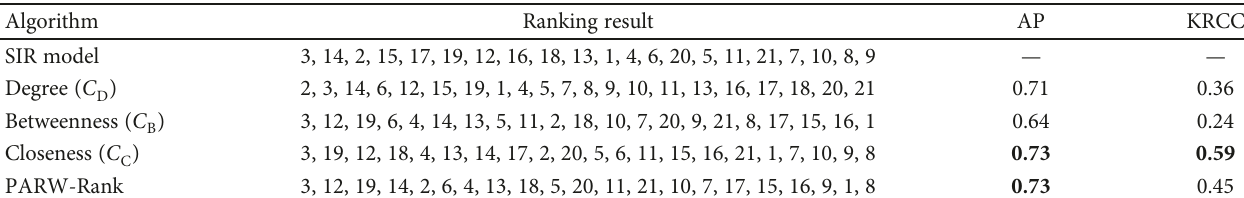
Figure 6: Topological structure of the ARPA Table 4: The ranking results and precisions of four algorithms and SIR-model for the ARPA network.